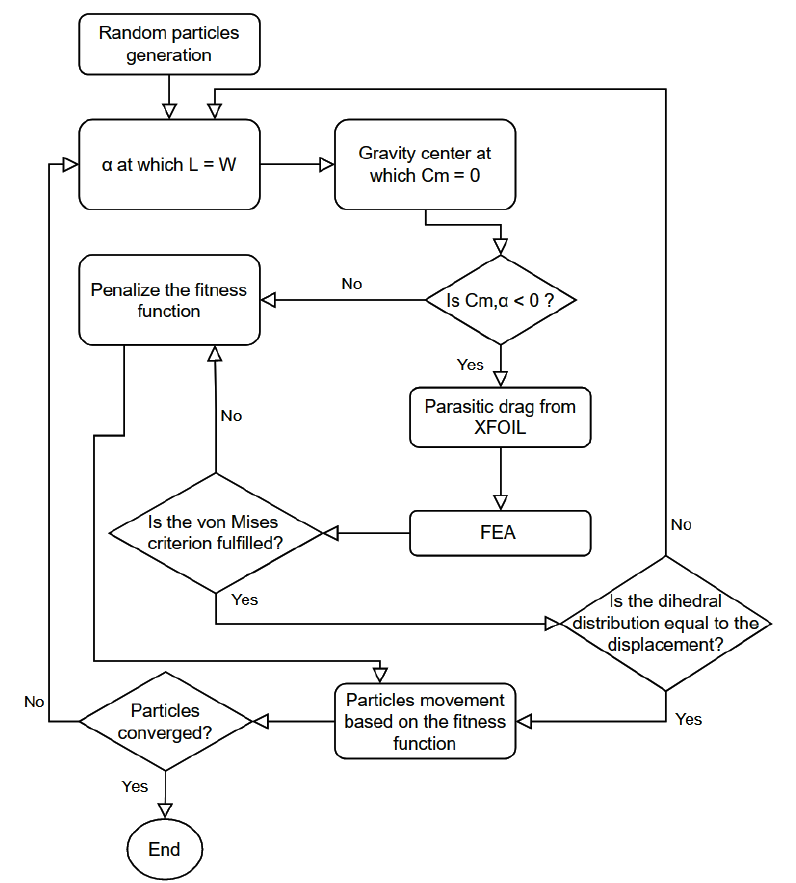
Figure 6. Flowchart of the